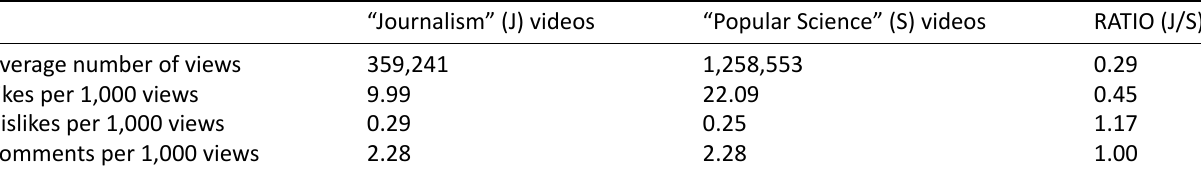
Table 2. Comparison of conventional measures of engagement for “Journalism” and “Popular Science” videos about AMR on